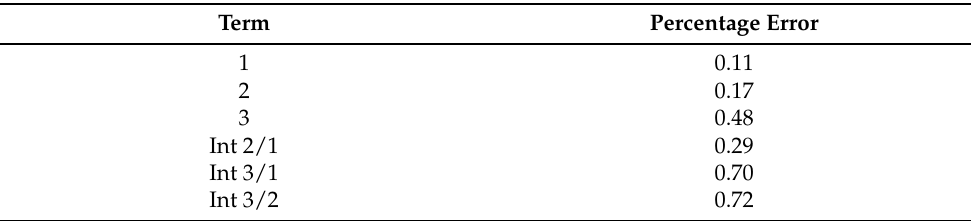
Table 5. Numerical integration error estimates (in percentage terms) for various marginal and interaction terms involved in decomposing the pre-catXL total annual aggregate variance. Column 1 indicates the particular marginal or interaction term, and Column 2 indicates the percentage